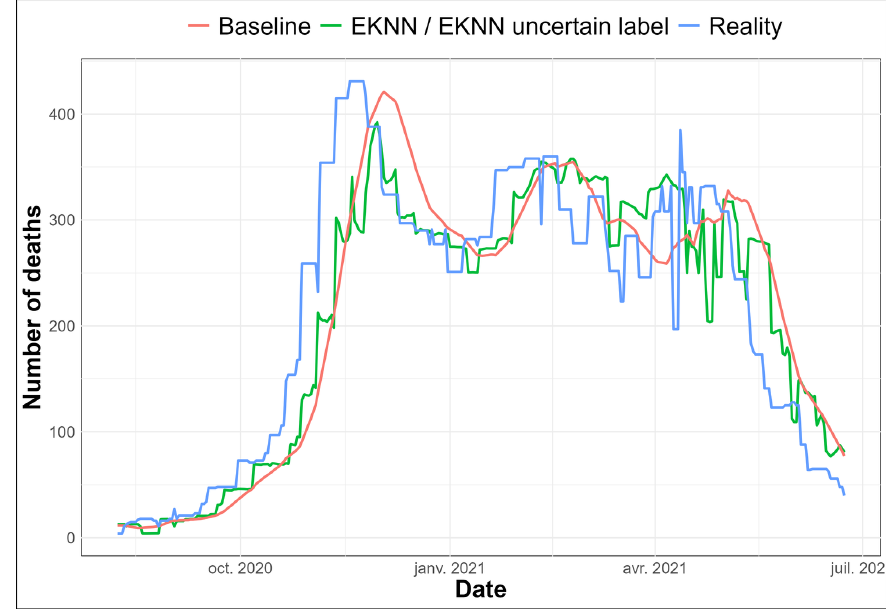
Fig 2. Predictive results on data imputed with time-E K NN imputation method, comparison with true labels: K = 1: q = 4: v =